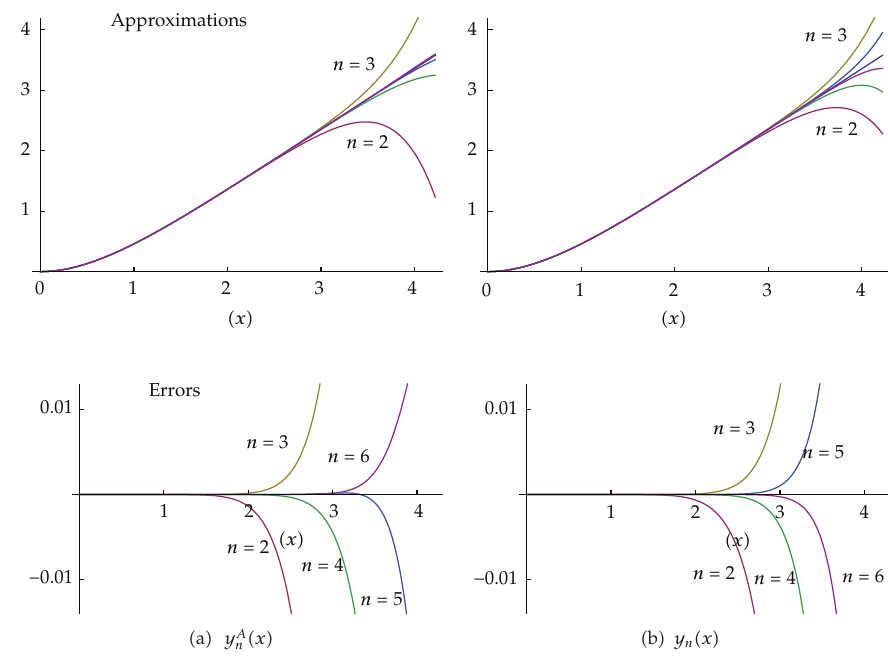
Figure 3: The Adomian solutions y A n (cid:3) x (cid:4) and their errors in (cid:3) a (cid:4) and presented solutions y n (cid:3) x (cid:4) and their errors in (cid:3) b (cid:4) for the Falkner-Skan equation with β (cid:6)